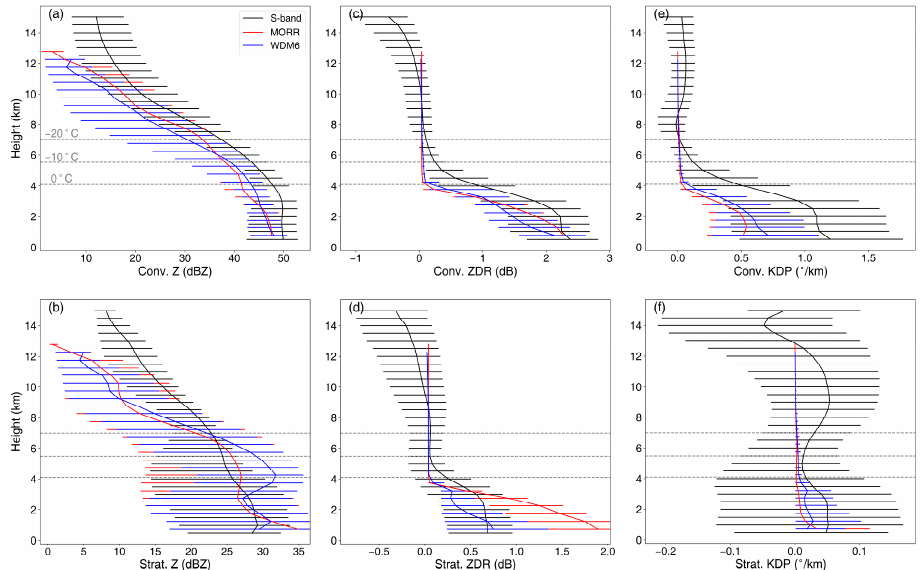
Figure 11. Comparison of ( a , b ) Z , ( c , d ) differential reflectivity ( Z DR ), and ( e , f ) specific differential phase ( K DP ) median profiles over (top) convective and (bottom) stratiform regions for S-POL radar and the MORR and WDM6 microphysics schemes in the sampling period 1200–1500 UTC. Error bars denote the interquartile range for each altitude layer. The gray dashed lines indicate the 0 °C, − 10 °C, and − 20 °C levels as recorded by soundings, with the lowest value at the bottom and the highest at the top.